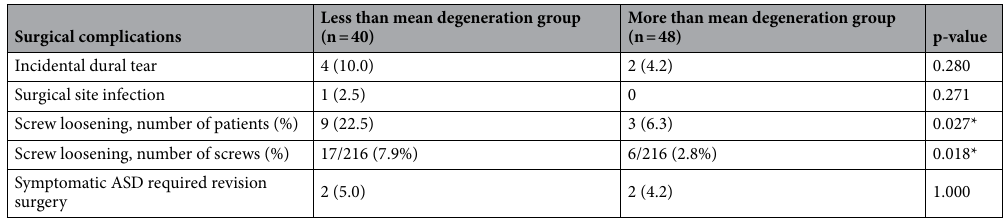
Table 4. Comparison of surgical complications between two facet joint degeneration groups. ASD adjacent segment degeneration. The data are presented as number (percentages). Statistical differences were examined by Chi-square test or fisher exact test. *indicated statistical